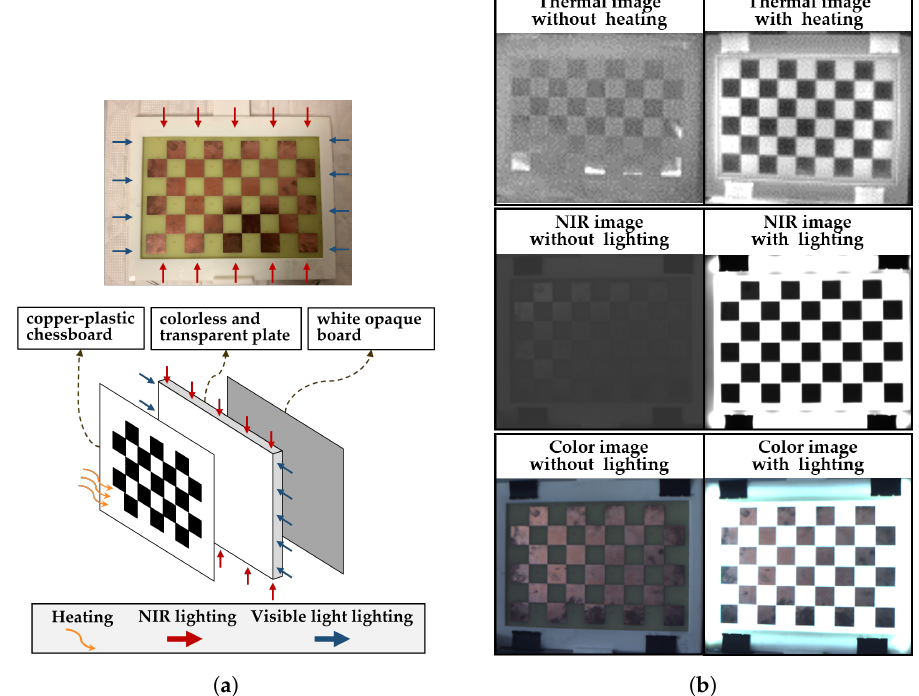
Figure 3. ( a ) A copper–plastic chessboard calibration target (upper) and its principle (bottom). ( b ) Comparison of calibration images with and without active lighting for color image, NIR image, and thermal